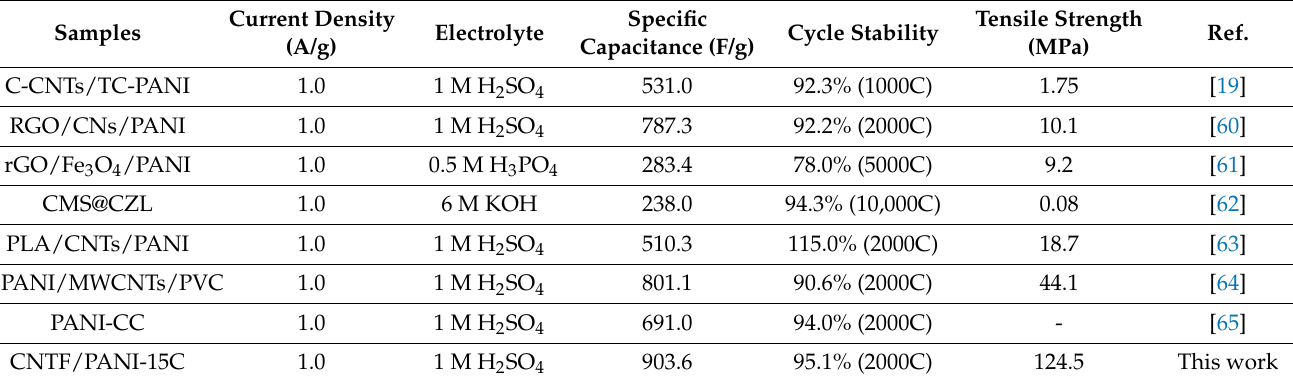
Table 2. Comparison of electrode performance reported in related